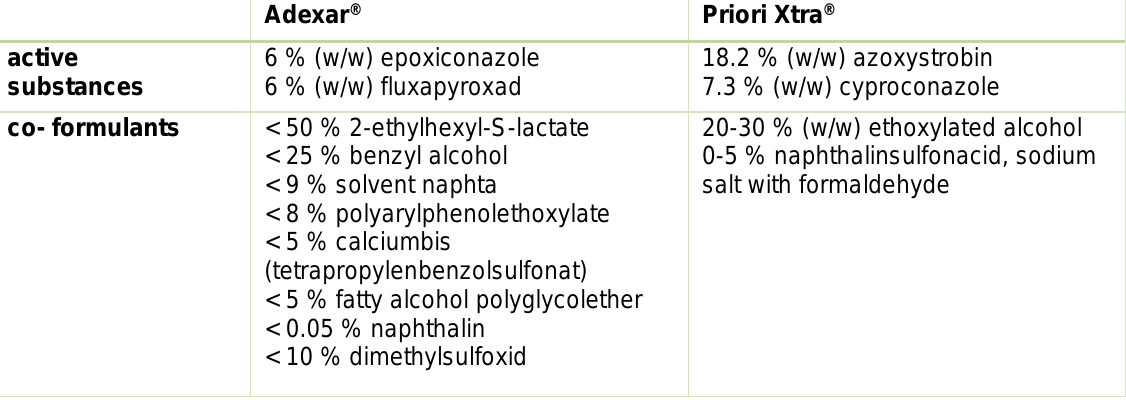
Table 1: Composition information on ingredients according to MSDS of Priori Xtra ® and Adexar ® Adexar